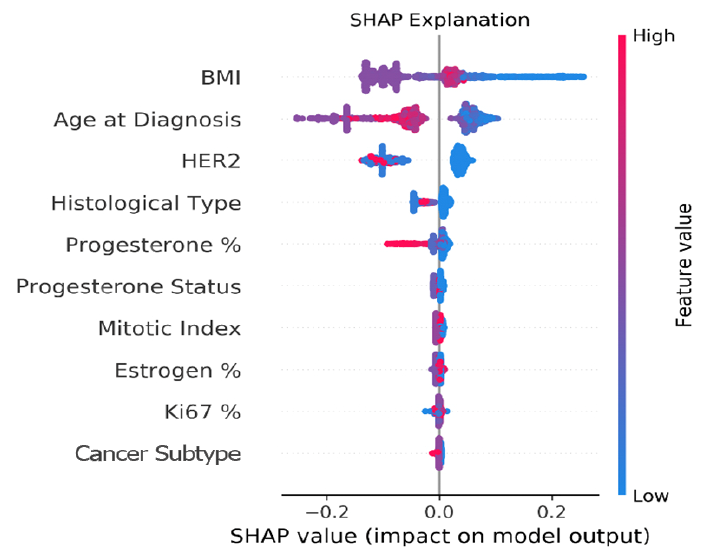
Figure 4. Clinical feature contributions. A summary plot of the SHAP values of top features in the clinical model. Each point represents a single patient. The x -axis indicates the effect (either positive or negative) of the feature on the predicted score for the patient. The point’s color represents the value of the features (red = high value, blue = low value, purple = close to the average value).